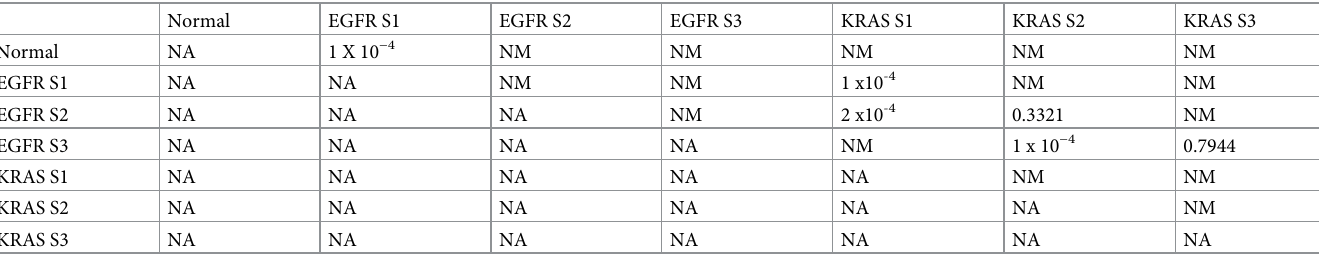
Table 3. P-value results of pairwise Mann-Whitney testing select conditions for N:C ratios of near-euploids. Normal